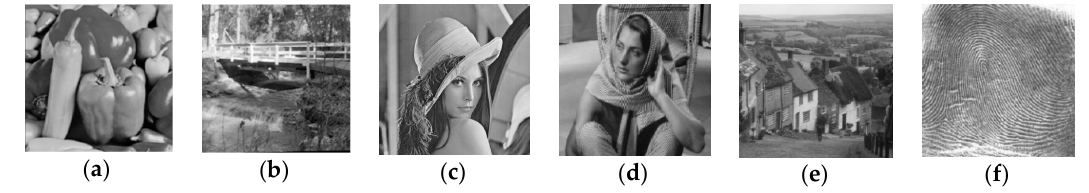
Figure 6. Different representative images of ( a ) Peppers, ( b ) Bridge, ( c ) Lena, ( d ) Barbara, ( e ) Goldhill, ( f ) Fingerprint. Table 2. The quantitative results (PSNR/SSIM) of different algorithms for the different types of images. Algorithm